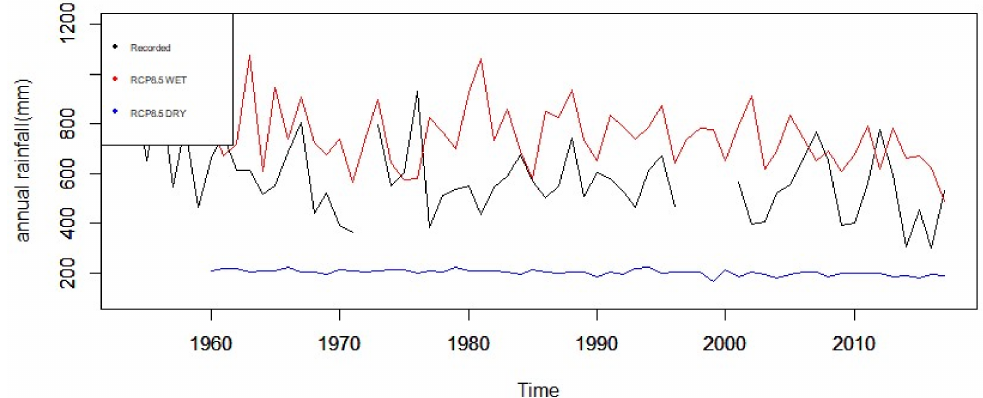
Figure 31. Klondyke farm annual rainfall.